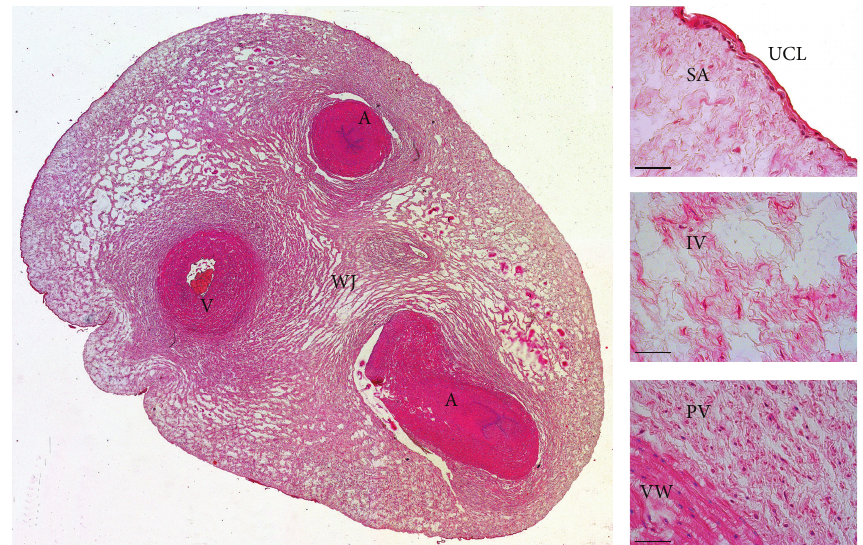
Figure 1: Cross-section of the human umbilical cord. A: artery; V: vein; WJ: Wharton’s jelly; UCL: umbilical cord lining; SA, IV, and PV: subamnion, intervascular, and perivascular zones of Wharton’s jelly; VW: blood vessel wall. Hematoxylin and eosin staining, scale bar = 200 𝜇